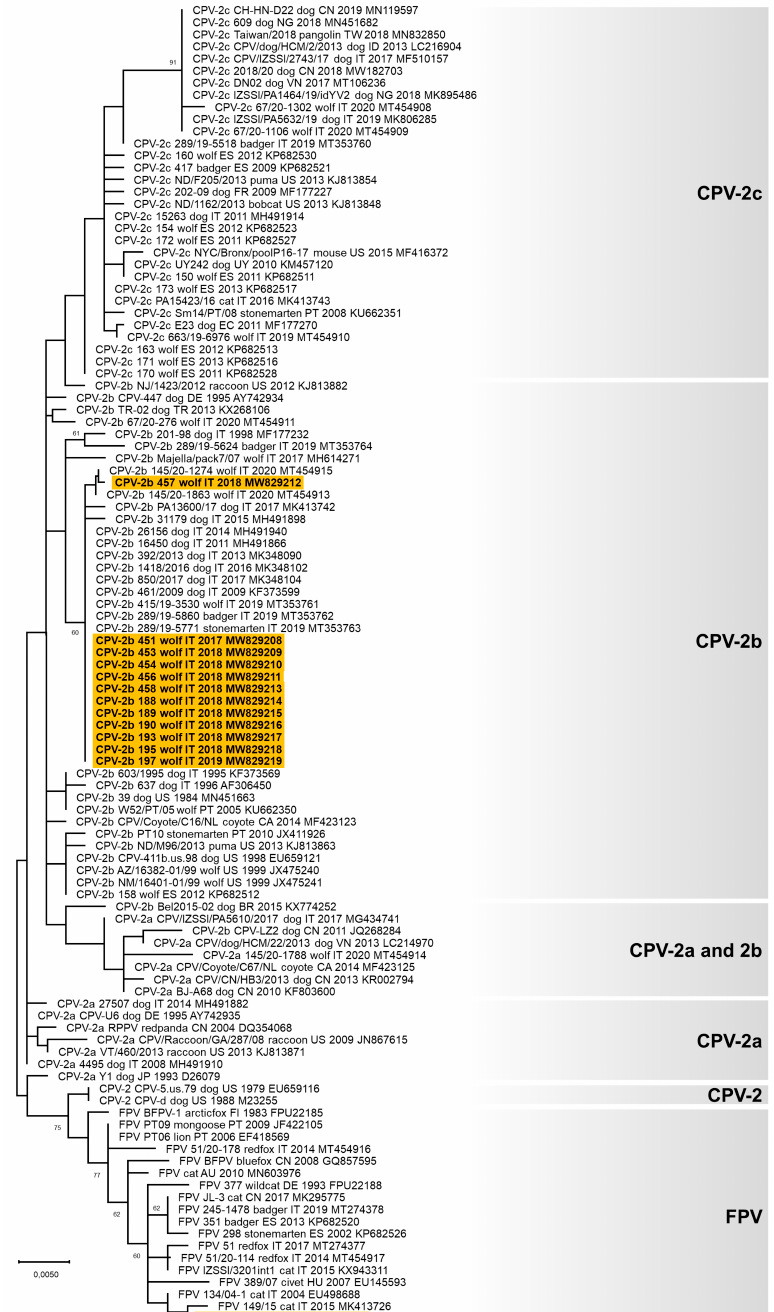
Figure 1. Unrooted phylogenetic tree constructed on the partial VP2 nucleotide sequences of car- nivore protoparvoviruses obtained in this study and reference strains in the GenBank database (Table S1), using the Neighbor-Joining method and the Tamura 3-parameters (T92) model with a gamma distribution. The robustness of the individual nodes on the phylogenetic tree was estimated using 1000 bootstrap replicates. Bootstrap values greater than 60% are indicated. The scale bars indicate the estimated numbers of nucleotide substitutions. Highlighted in yellow: sequences of canine parvovirus type 2 (CPV) and feline panleukopenia virus (FPV) generated in this study. In black on the right of the figure are indicated the six groups evidenced in this study. A complete hexon gene nucleotide sequence of 2718 nts in length and a complete fiber gene nucleotide sequence of 1632 nts in length were obtained for one CAdV-1 (lab ID: 452/2017, GenBank ID: MW829199 and MW829200, Table 2 and Table S2). From